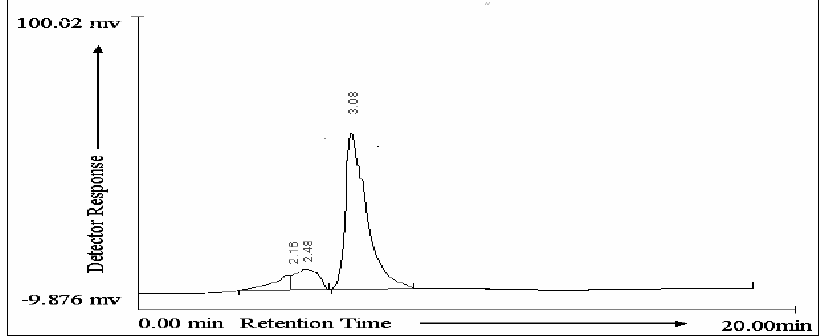
Figure 5. Chromatogram showing degradation in 0.1 M